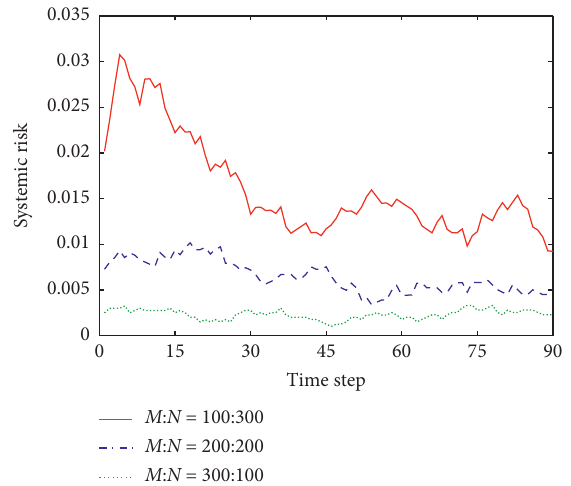
Figure 5: The impact of the change in the number combination between the shadow banks and the commercial banks on the systemic risk curve (the parameter setting is the same as in Figure 3 except for M and N